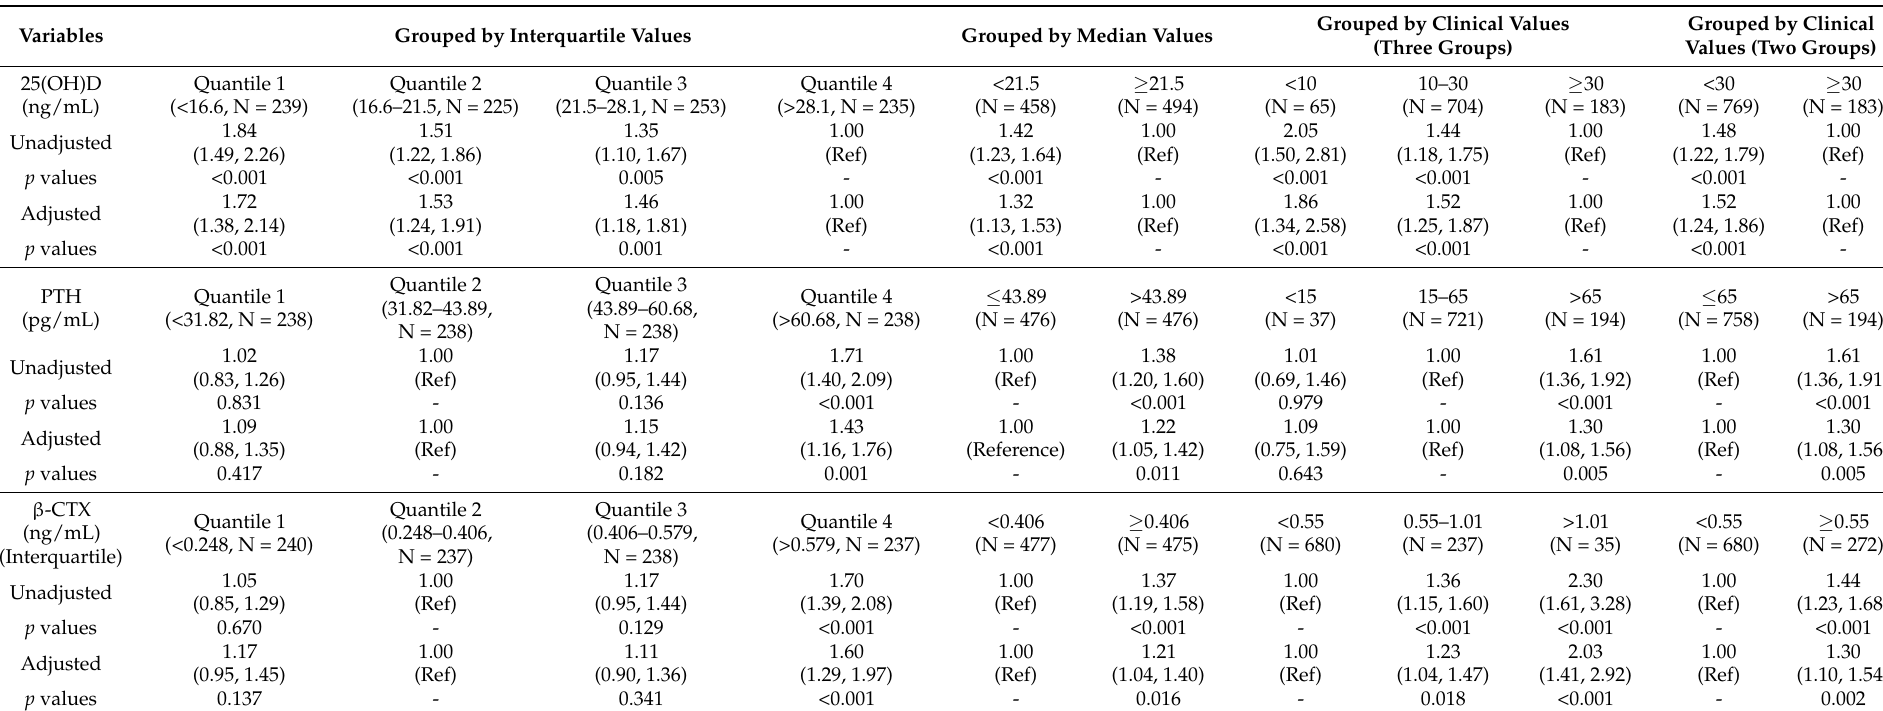
Table 2. Cox regression analyses of the associations of 25(OH)D, PTH, and β -CTX with all-cause mortality in centenarians.